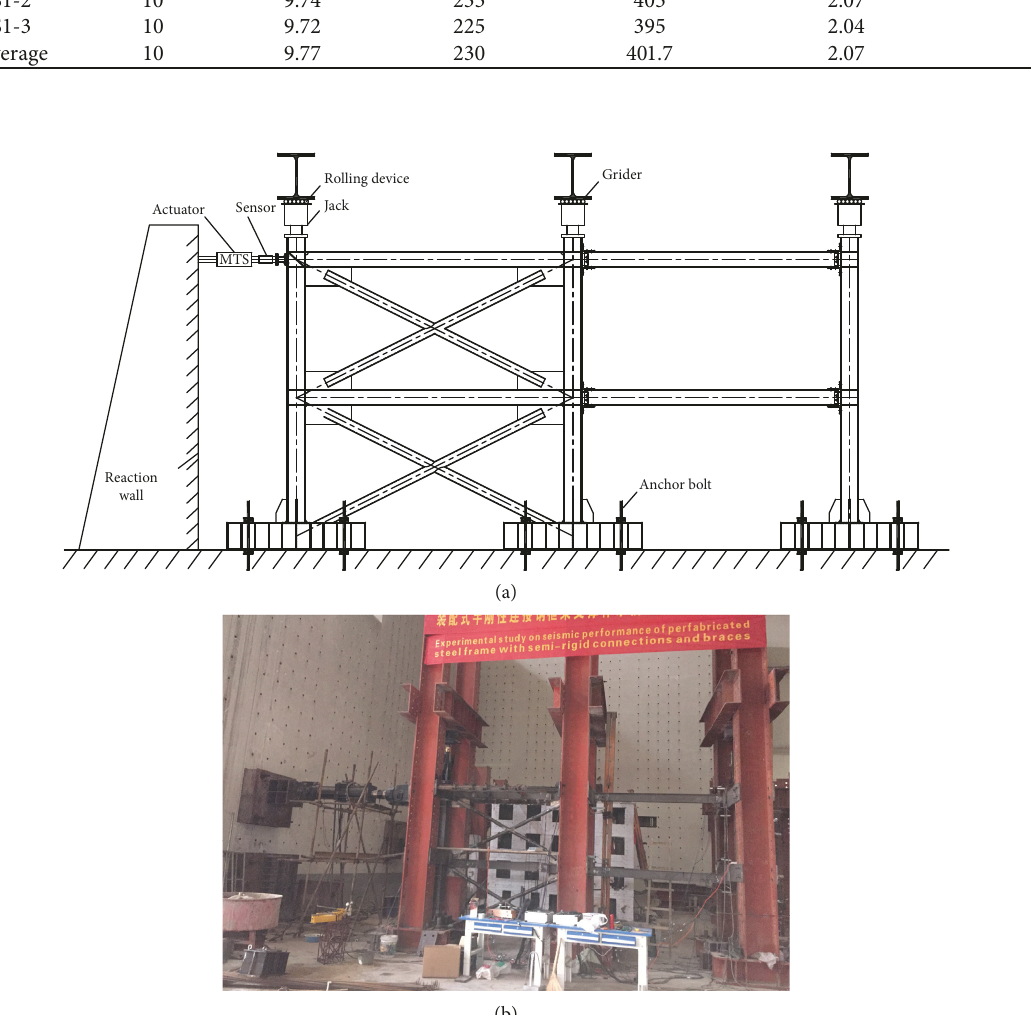
Figure 3: Test setup. (a) Schematic of the test setup. (b) Actual test setup.